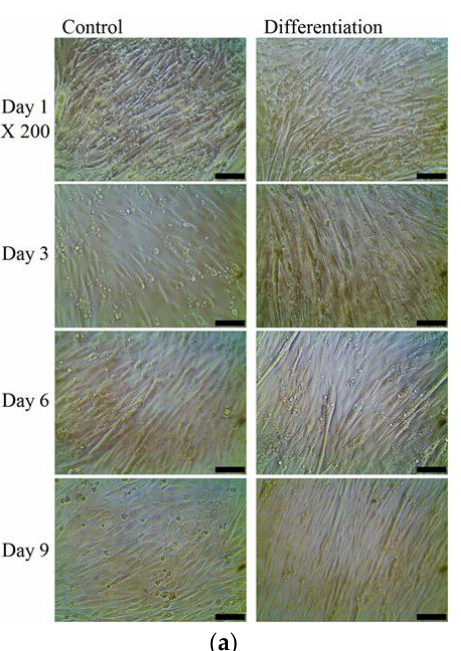
Figure 2. ( a ) AFM image and ( b ) height data of the extracellular matrix gel coated on the ITO electrode; ( c ) impedance magnitude and ( d ) phase of the bare or gel-coated ITO electrode in 0.9% NaCl electrolyte.